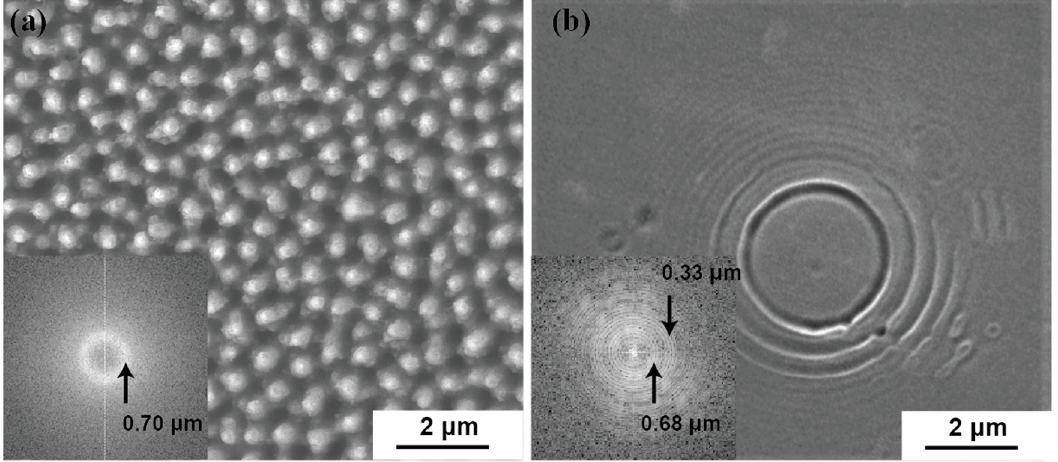
Figure 3. ( a ) Top view FESEM image of silicon foil with laser irradiation in water. ( b ) Top view FESEM image of silicon foil with single pulse irradiation. The insets show Fourier transforms of the images, respectively.